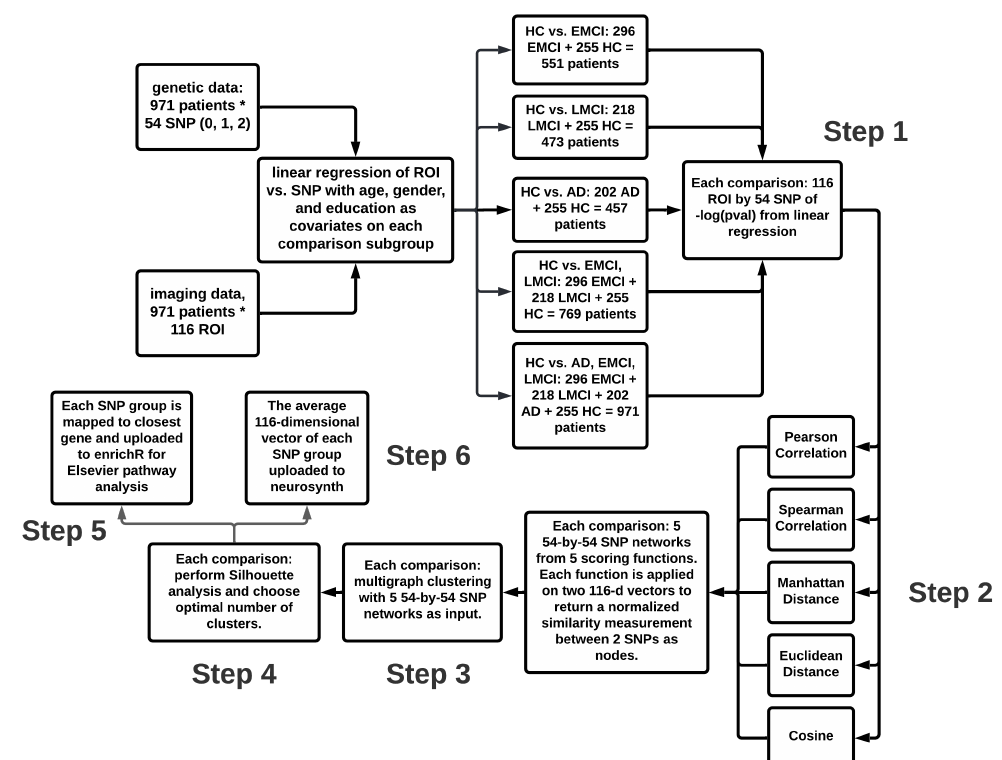
Figure 1. Flowchart of our analysis pipeline. Step 1 generates detailed SNP-QT association maps (54 SNPs by 116 QTs) for five different subject sets examined in our previous study [23], respectively. Step 2 transforms the SNP-QT map to SNP networks by applying different similarity scoring functions to each pair of 116-dimensional SNP vectors. Step 3 uses multigraph min-max cut algorithm to generate an optimal clustering result scoring analysis in Step 4. In Step 5, the SNPs in each cluster are mapped to nearest genes and uploaded to enrichR for Elsevier pathway analysis to identify relevant biological pathways. In Step 6, Neurovault and Neurosynth are used to functionally annotate the average brain association pattern for all the SNPs in each